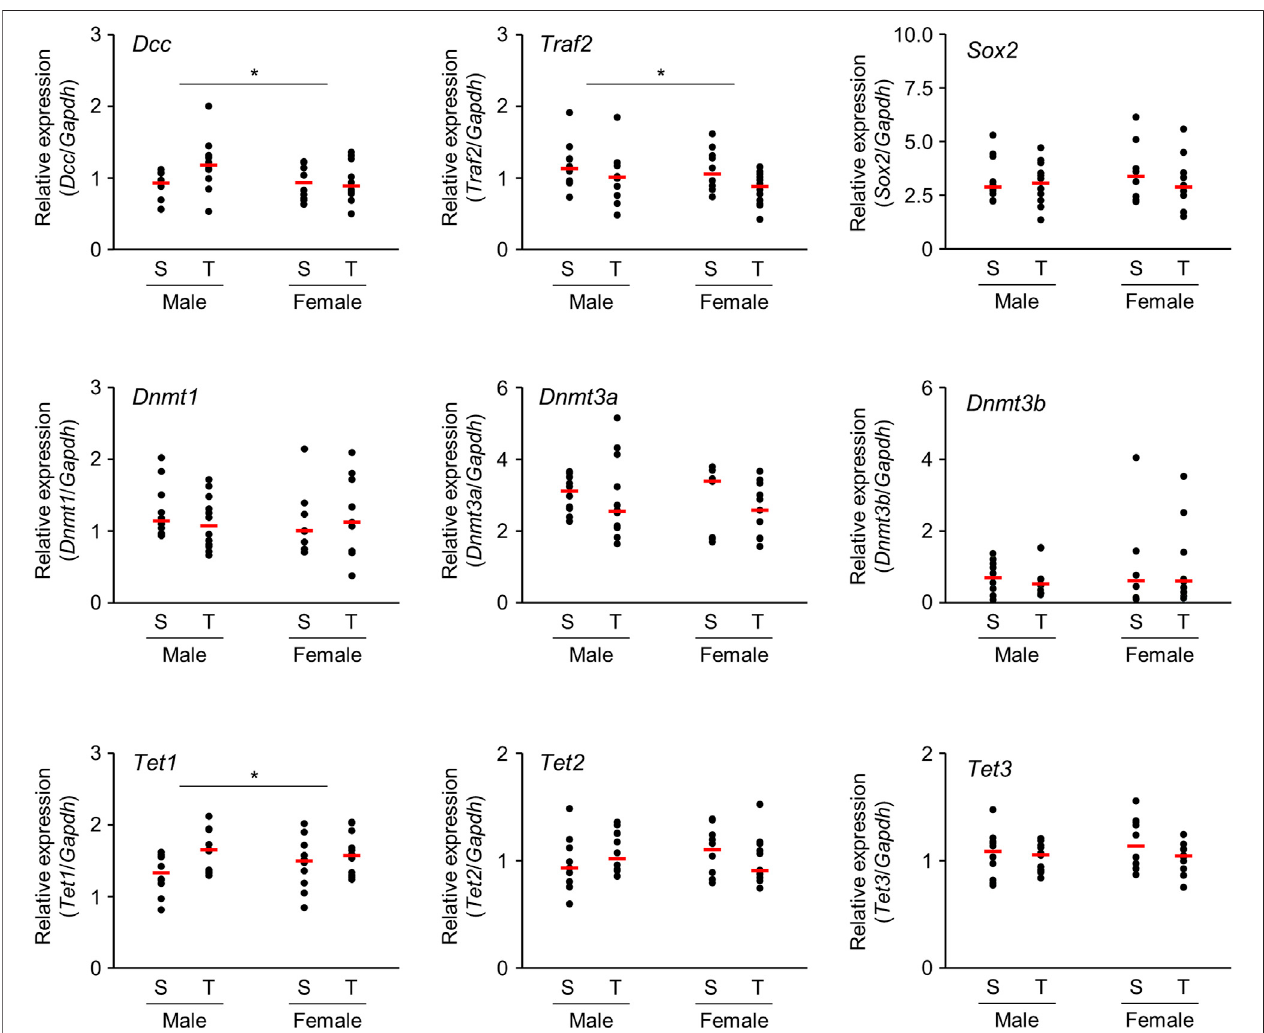
FIGURE5| ScatterplotsofbrainmRNAexpressionlevelsof1-day-oldoffspringmicefromTiO 2 -HandShamgroupsdeterminedbyqRT-PCR.TotalRNAobtained from each sample {two offspring were randomly selected from each dam [Sham (S): n (cid:2) 5, TiO 2 -H (T): n (cid:2) 6]} was transcribed to cDNA and subjected to qRT-PCR analysis. Two-way ANOVA with exposure and sex as factors, followed by post-hoc Tukey test. * p < 0.05: main effect of TiO 2 -NP exposure on expression (Sham vs. Exposure).